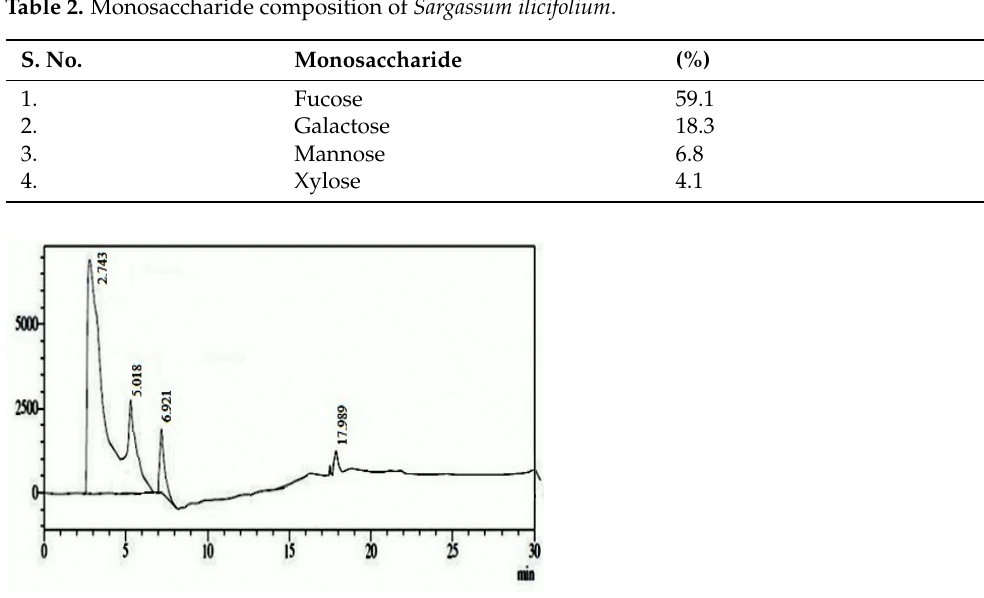
Figure 1. Chromatogram of fucose, galactose, mannose and xylose from hydrolysate fucoidan Sargassum ilicifollium .